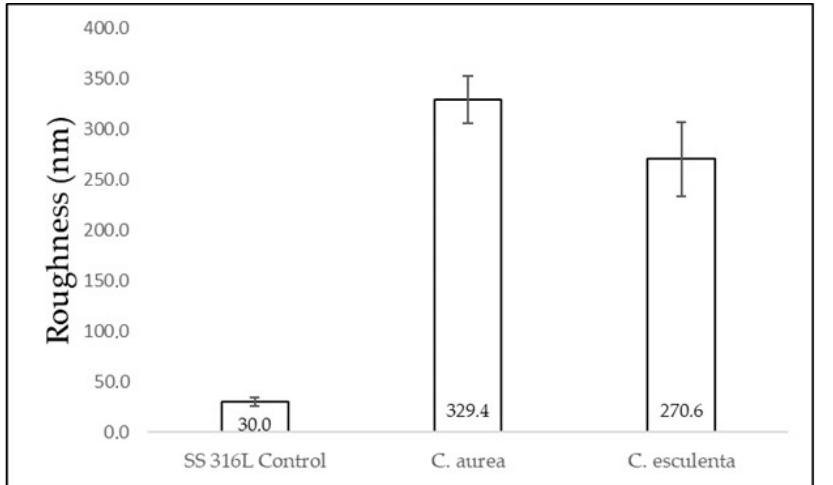
Figure 3. Average roughness of control (SS 316L) surface and natural leaves.